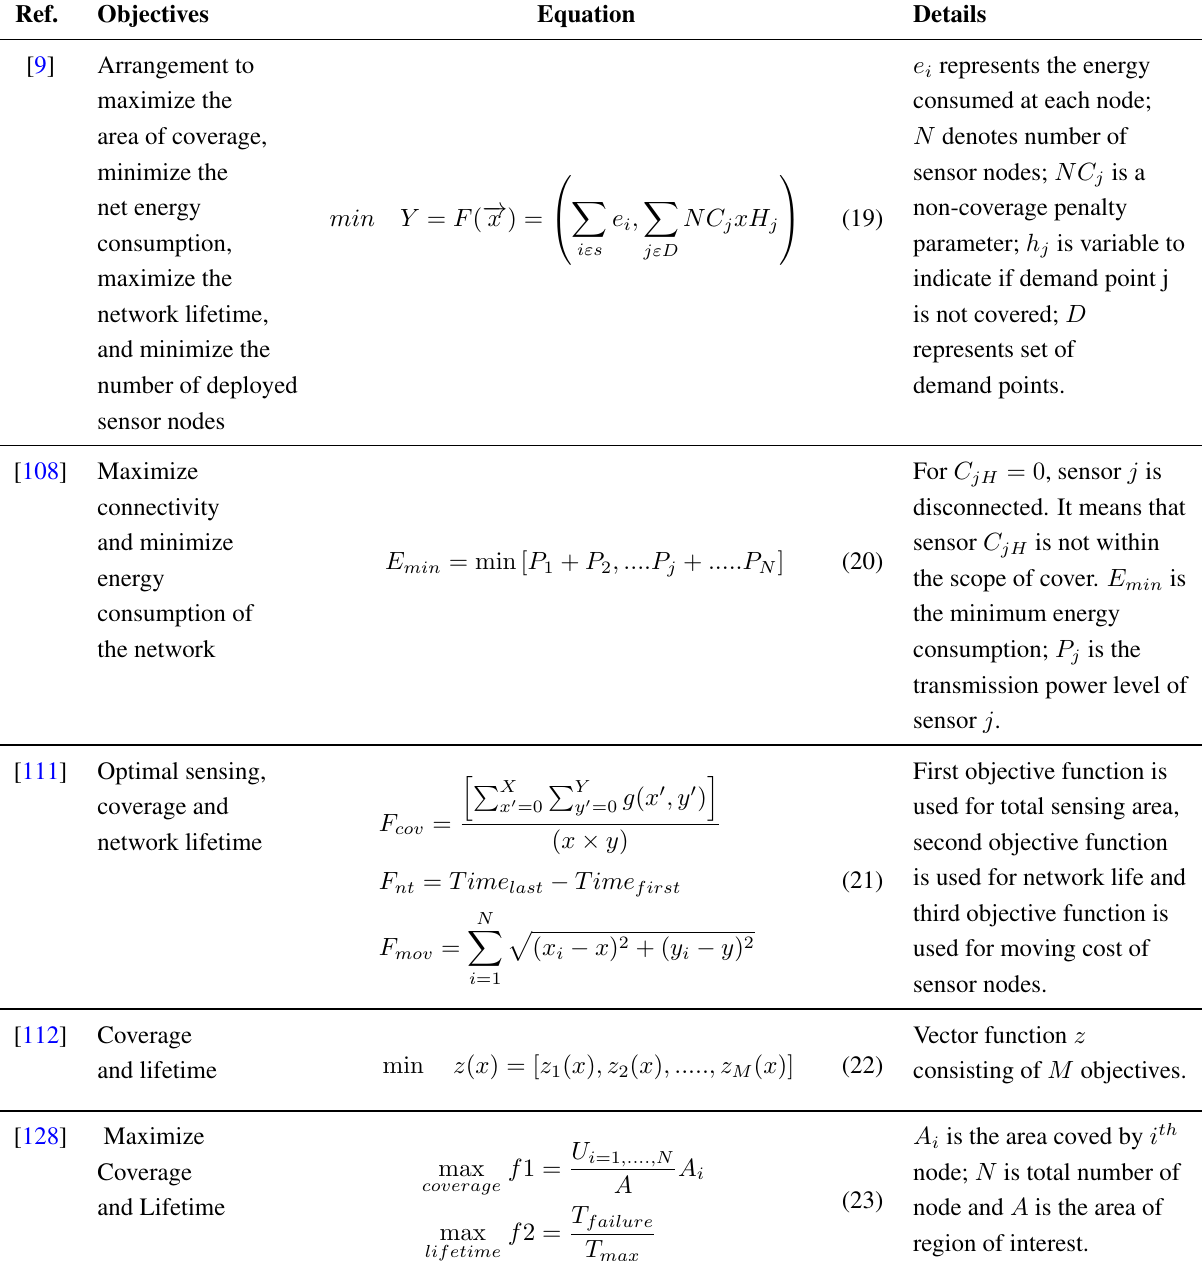
Table 4. Deployment related objectives in wireless sensor